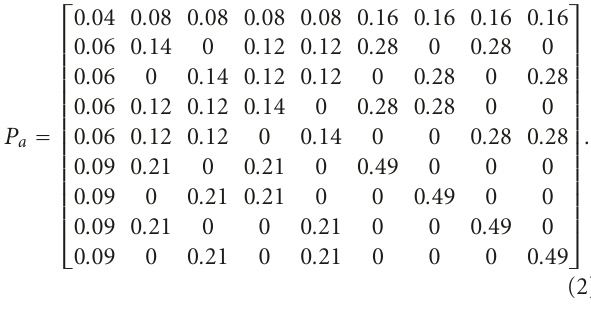
SIMMd mobility profile is defined by p = 0 . 05 and q = 0 .